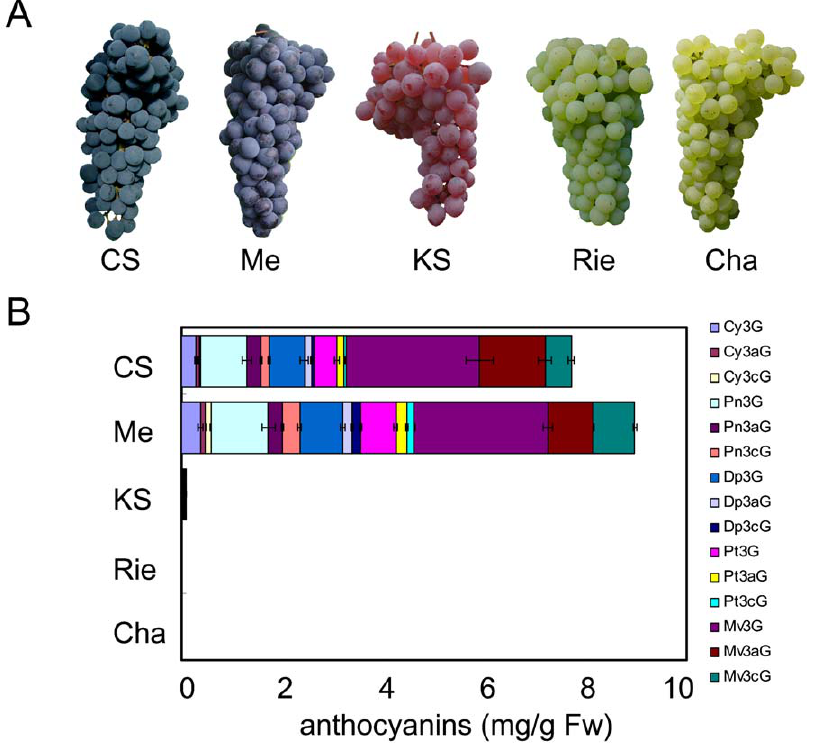
Figure 1. Anthocyanins in berry skin of grapes. (A) Features of bunches. (B) Total amounts of anthocyanins. Measurement of anthocyanins was performed as described in Materials and Methods.Experimental Procedures. Bars indicate means 6 standard deviations of duplicate experiments. CS: Cabernet Sauvignon, Me: Merlot, KS: Koshu, Rie: Riesling, Cha: Chardonnay.